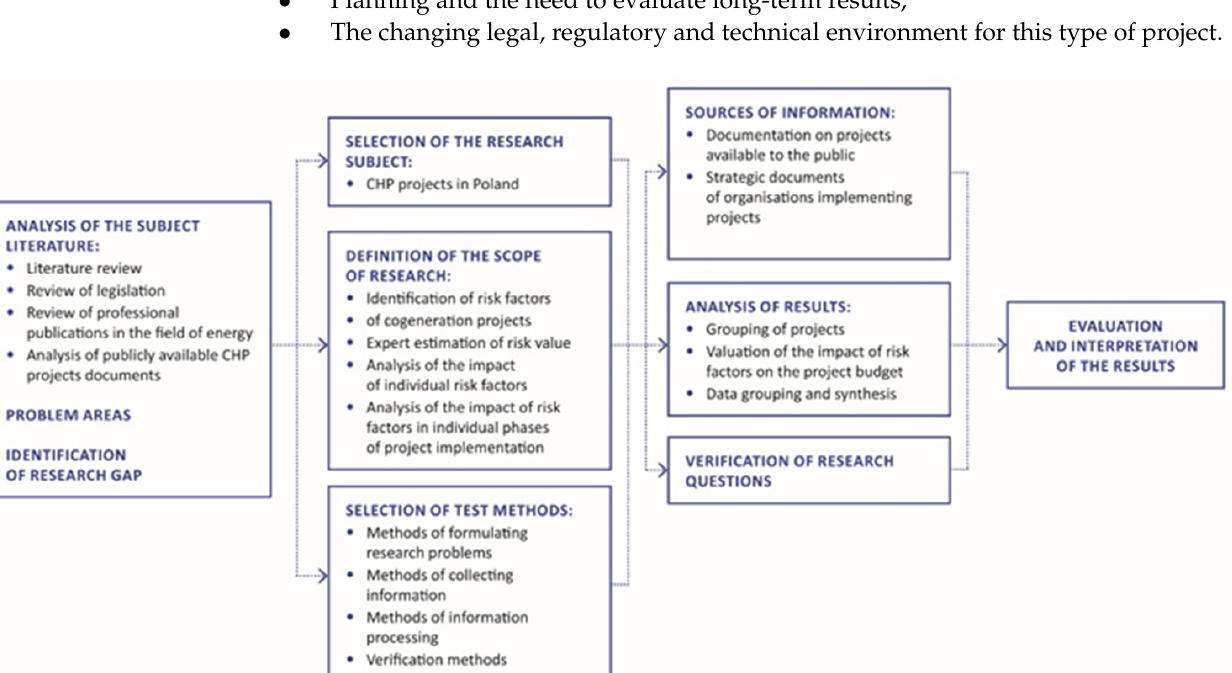
Table 4. Cogeneration projects under discussion.